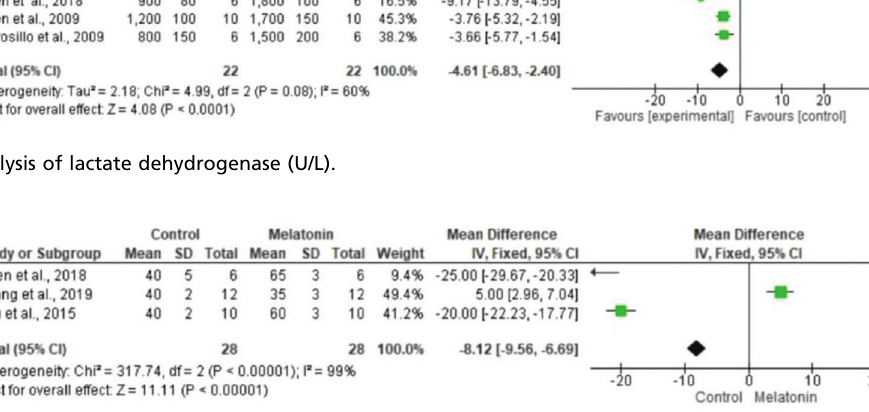
Figure 3d - Metanalysis of ejection fraction measured by echocardiography (% left